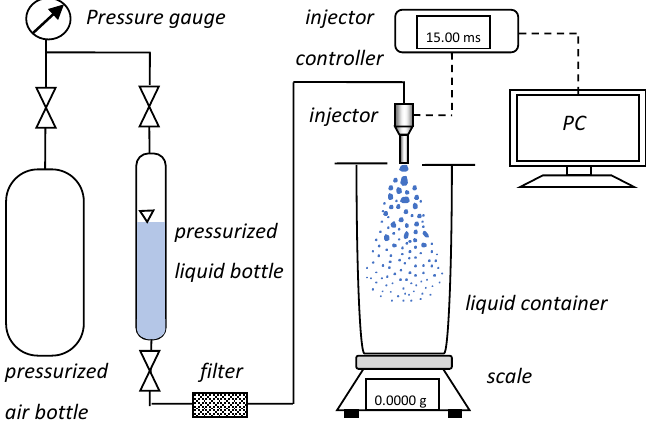
Figure 14. Schematic diagram of the experimental set-up for flow measurements.